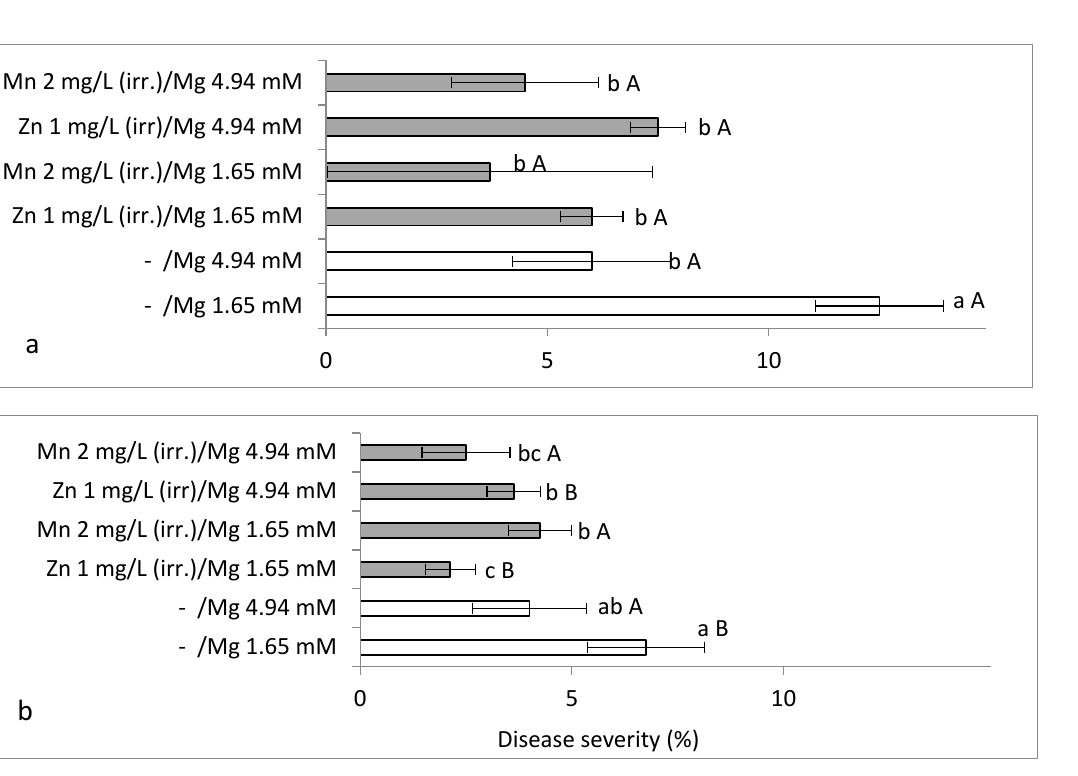
Table 2. Concentrations of nutritional elements in the shoots of sweet basil plants grown under commercial conditions and treated with two Mg concentrations (applied through the irrigation solution) and with Zn and Mn (applied through the irrigation solution) at 90 days after planting (Experiment C4, Spring 2017).